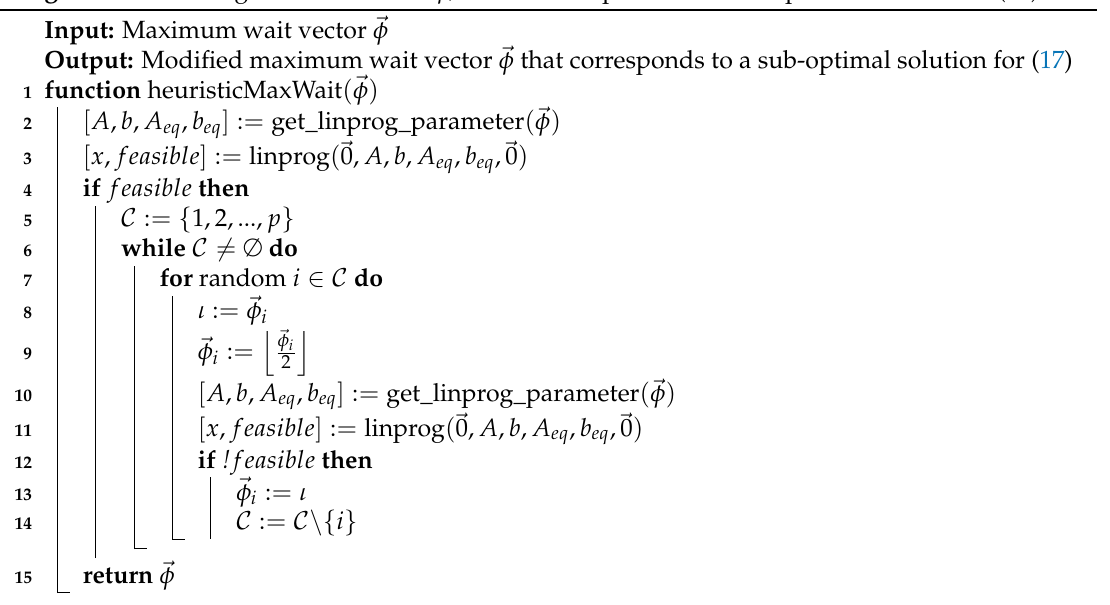
Algorithm 1: The algorithm to obtain (cid:126) φ , which corresponds to a sub-optimal solution for